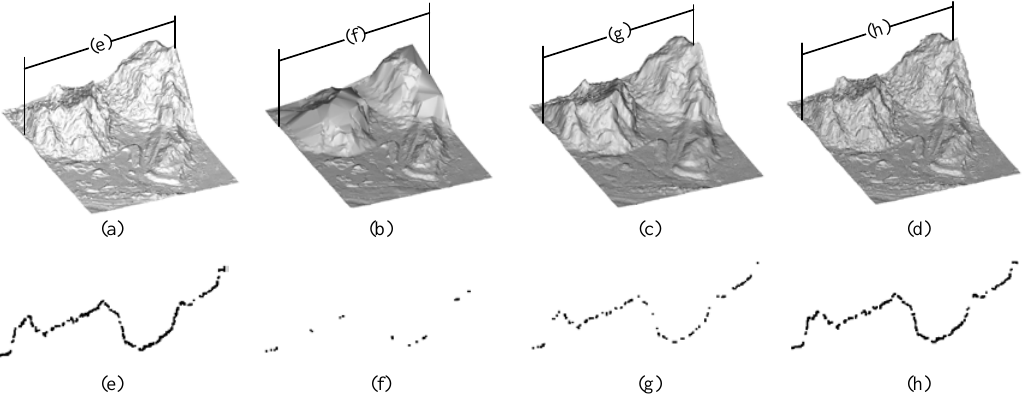
Figure 19. Comparison of DTM generated by PTDF, CSF and our algorithm. ( a ) Reference DTM, ( b ) DTM generated from PTDF, ( c ) DTM generated from CSF, ( d ) DTM generated from our algorithm. Filtering results for the cross-section for ( e ) reference data, ( f ) PTDF, ( g ) CSF, and ( h ) our algorithm.